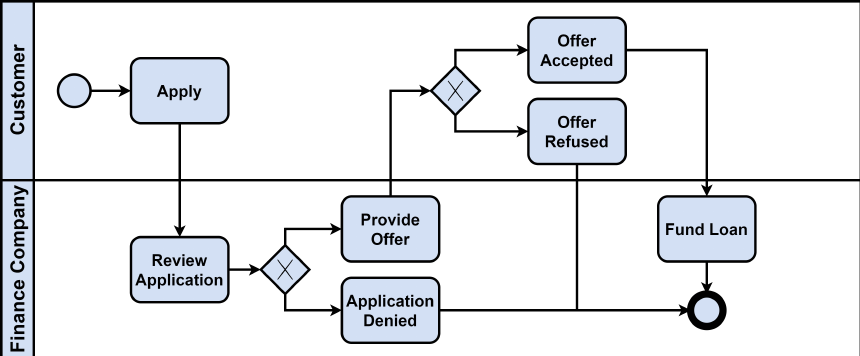
Figure 7. Illustrative diagram of the loan process.